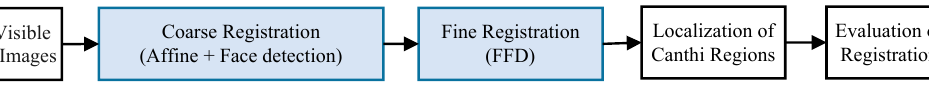
Figure 2. Block diagram of the two-step registration strategy.